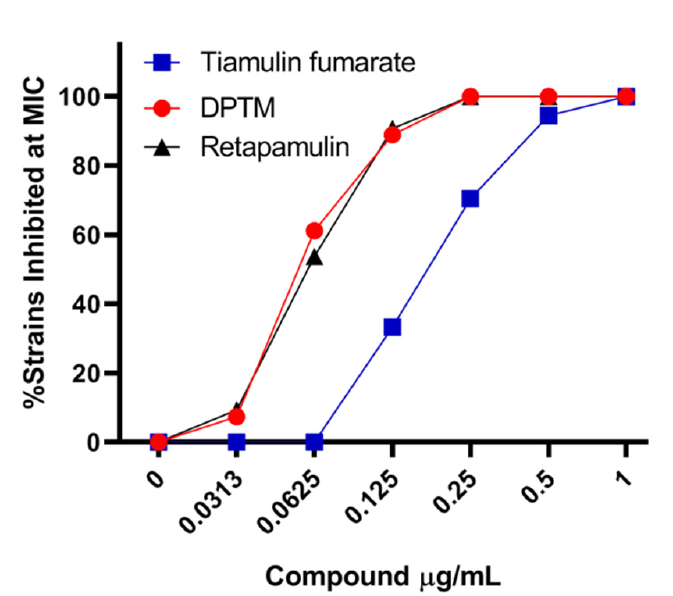
Figure 2. Assessment of DPTM and tiamulin fumarate against clinical isolates of MRSA. Full listing of this MIC data is in Table